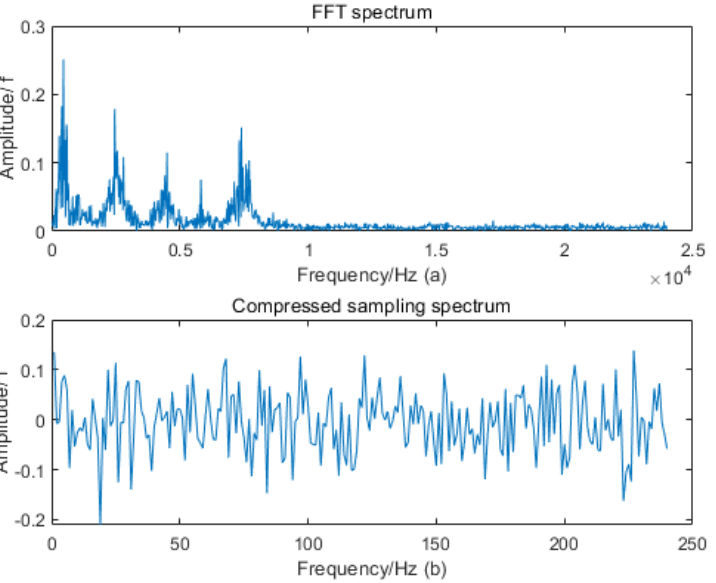
Figure 2. Feature representation of compressed sampling signals in the transform domain. ( a ) Spec- trogram with Fourier transform matrix added to the original signal. ( b ) The compressed sampling signal of spectrogram